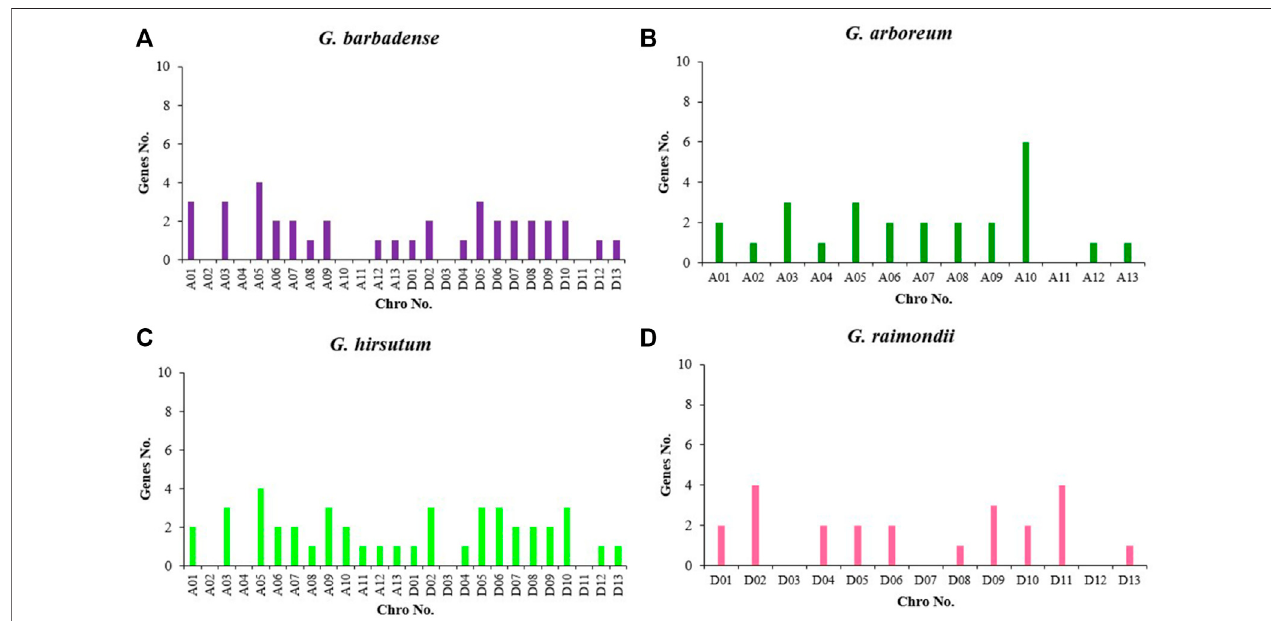
FIGURE 4 | Distribution of the number of genes in the KCS genes family of four cotton species. (A) G. barbadense ; (B) G. arboreum ; (C) G. hirsutum ; (D) G. raimondii .